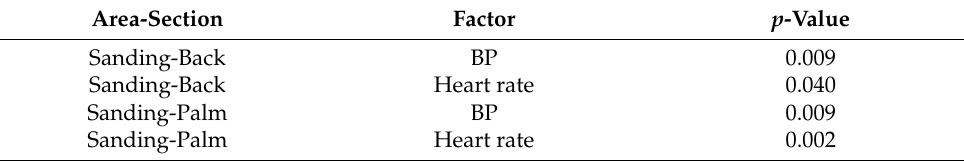
Table 9. Summary of models by zone, hand section, and factors included. Area Hand Section